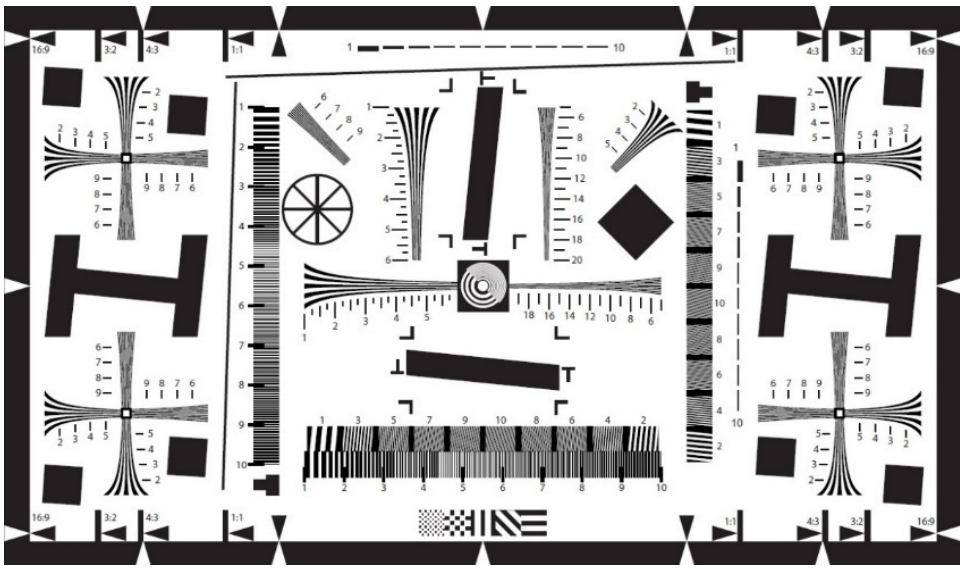
Figure 10. ISO-12233 chart for image sharpness evaluation [58].